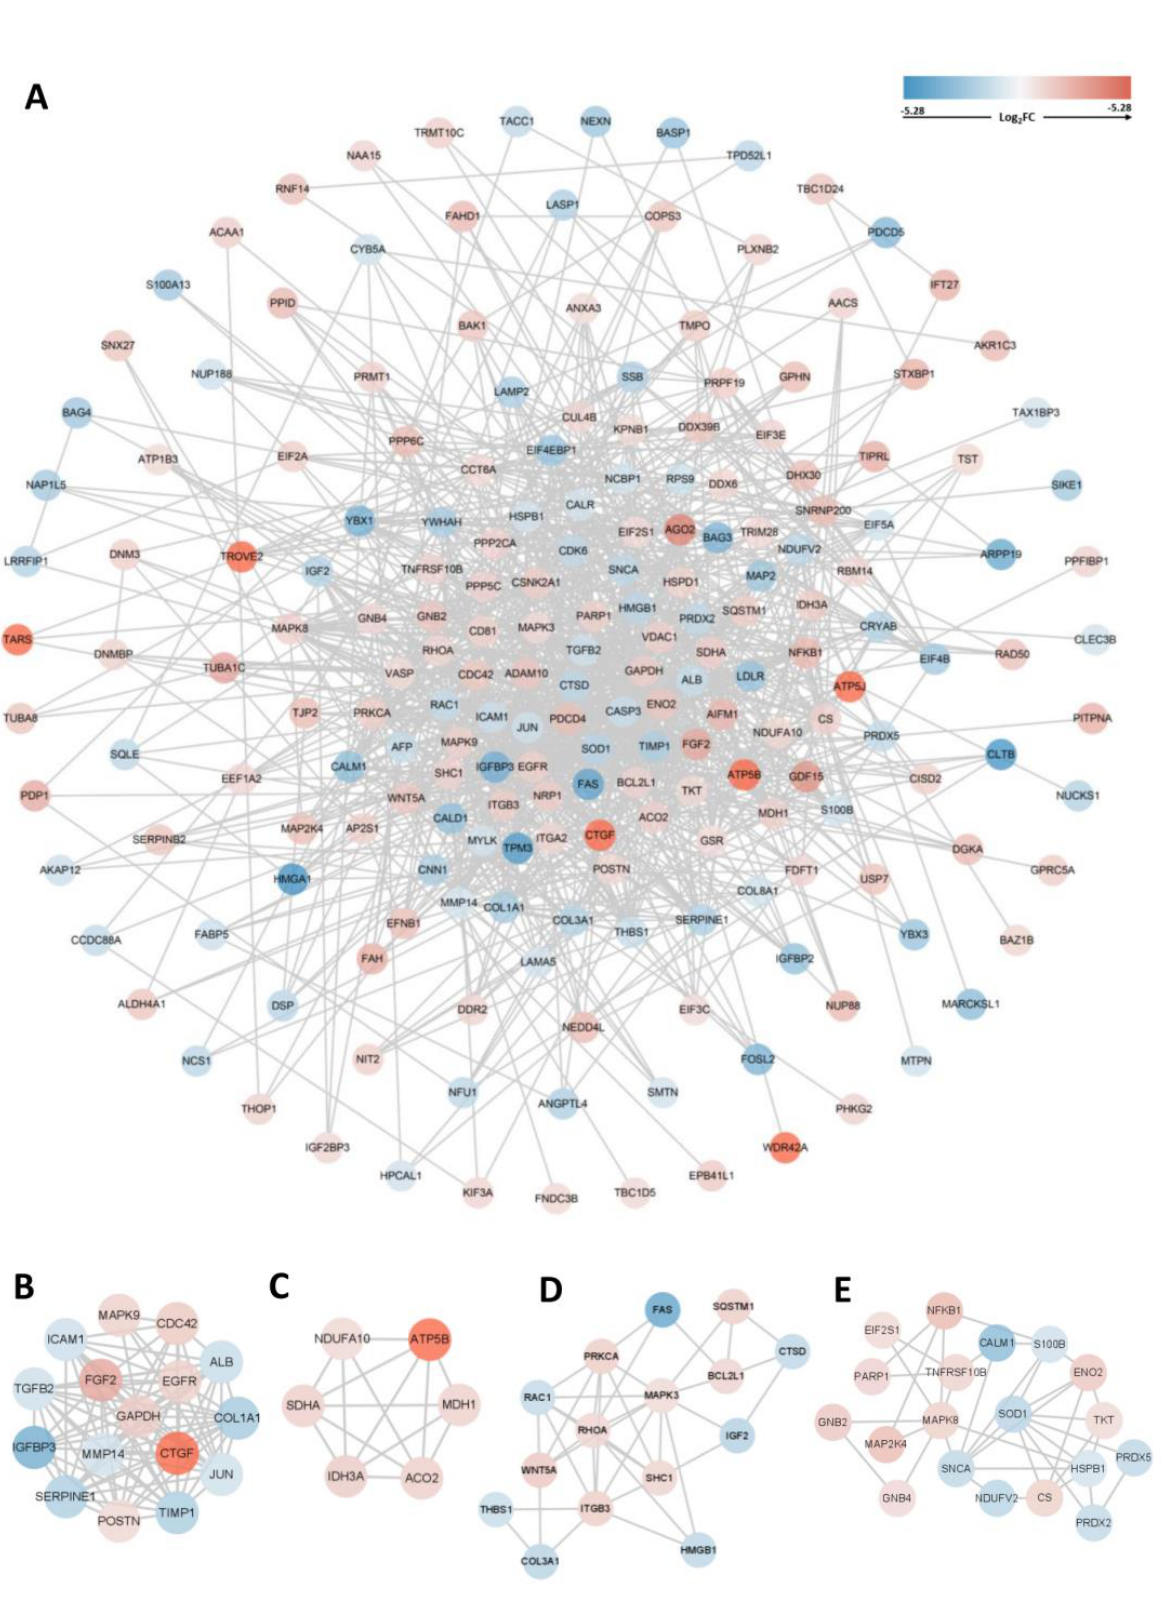
Figure 5. PPI network and module analysis. ( A ) PPI network of 211 common genes and ( B – E ) top four gene cluster